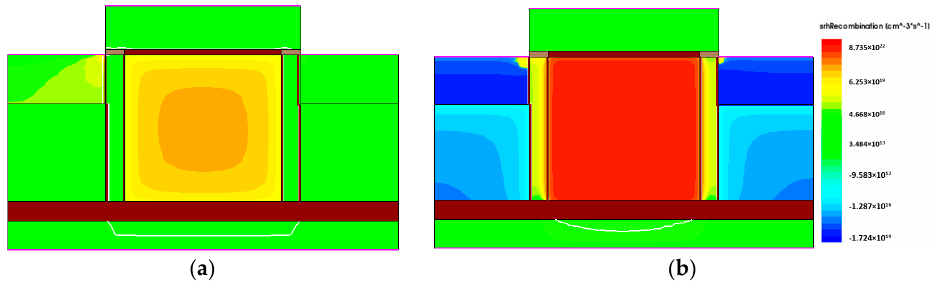
Figure 7. Distributions of the Shockley-Read-Hall (SHR) recombination rates under hold-1 condition at ( a ) 300 K and ( b ) 500 K.